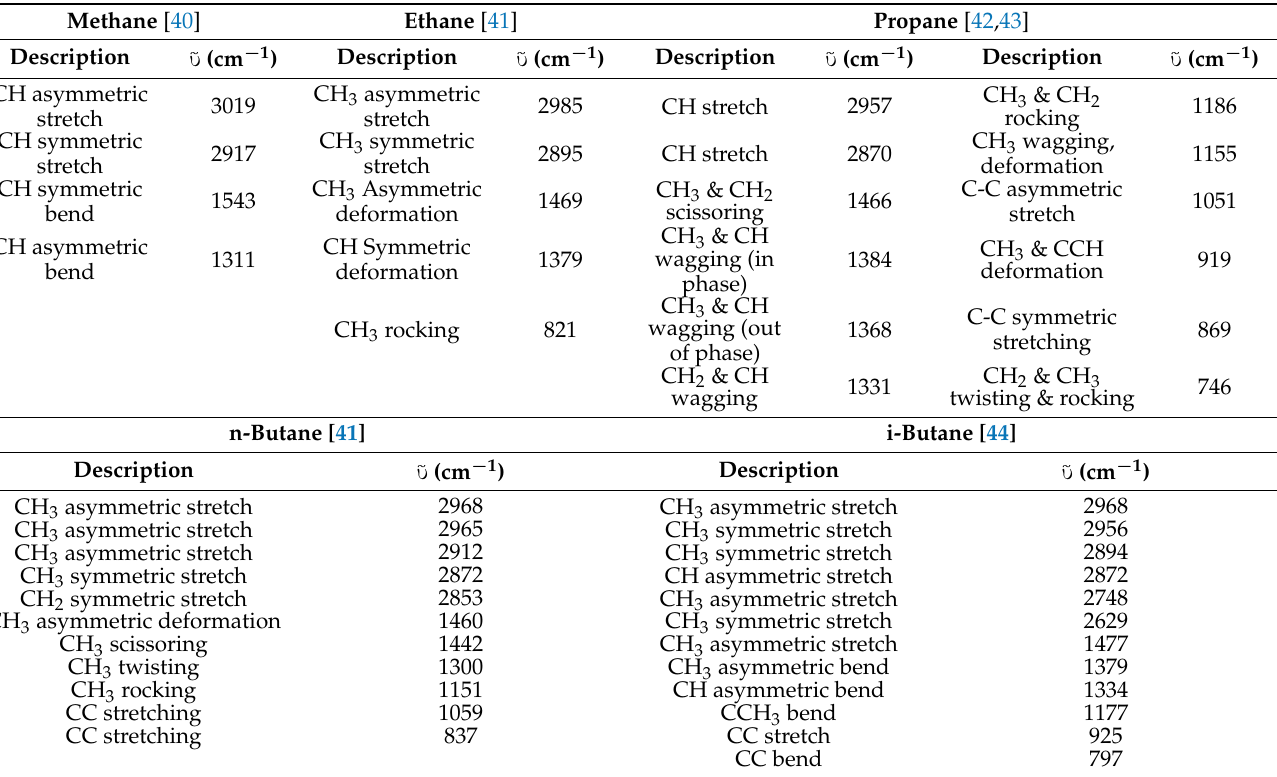
Table 2. Collection of the most relevant MIR spectral peaks, and their chemical assignations, for typical hydrocarbon constituents of